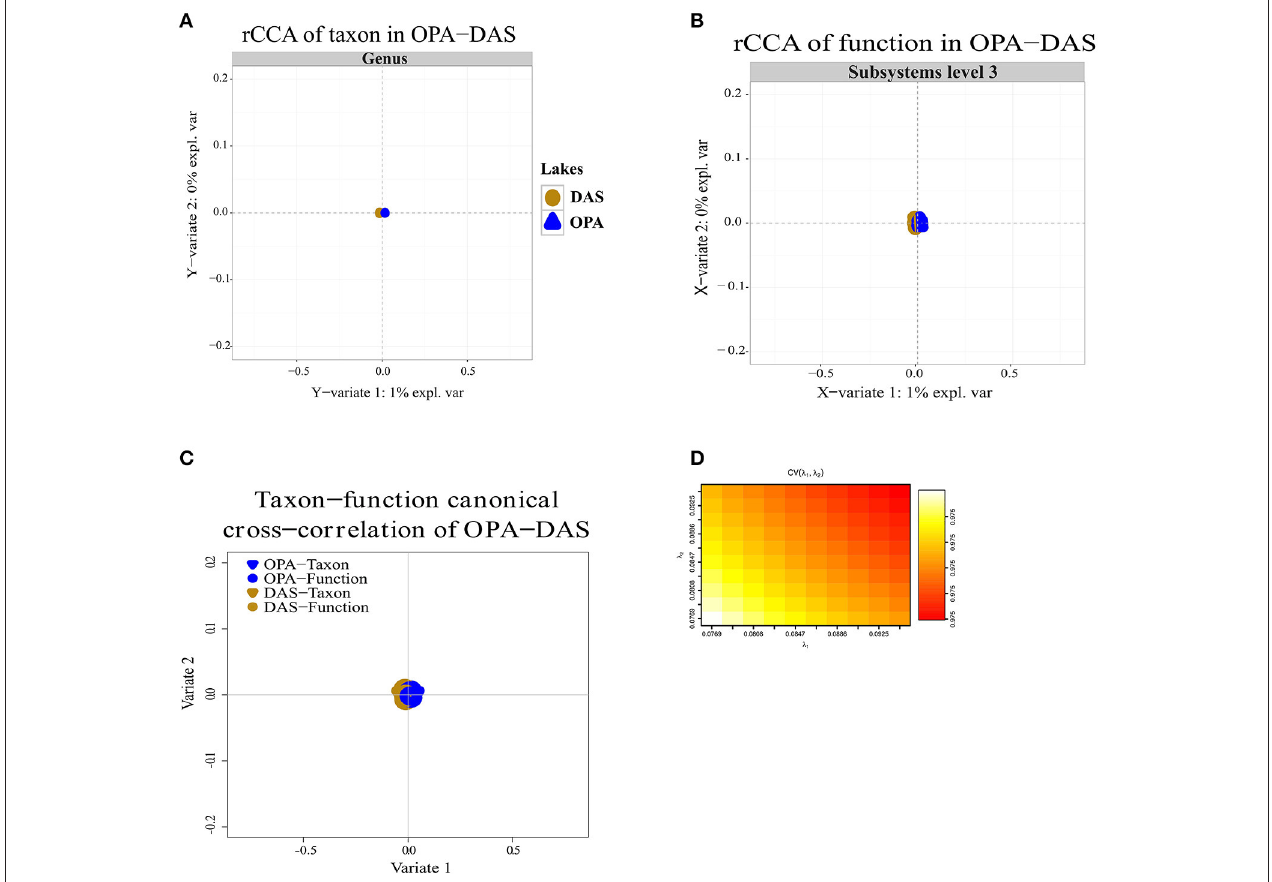
FIGURE 6 | Coupling of taxon and function between metacommunities based on the subsampled reads approach. (A–D) Regularized canonical correlation analysis (rCCA) performed on OPA-nc, and DAS-lc. (A) rCCA of the taxon (relative genus abundance) showed 1% of the explained variance on the first canonical component. (B) rCCA of function (subsystems level3 relative abundance) also showed 1% of the explained variance on the first canonical component. (C) The canonical cross-correlation of taxon-function identified a coupling pattern between taxon and function. (D) Cross-validation score converged to a maximum value of 0.975 when regularization parameters λ 1 and λ 2 were both fixed at 0.0925. The rCCA method was applied using mixOmics and CCA package in